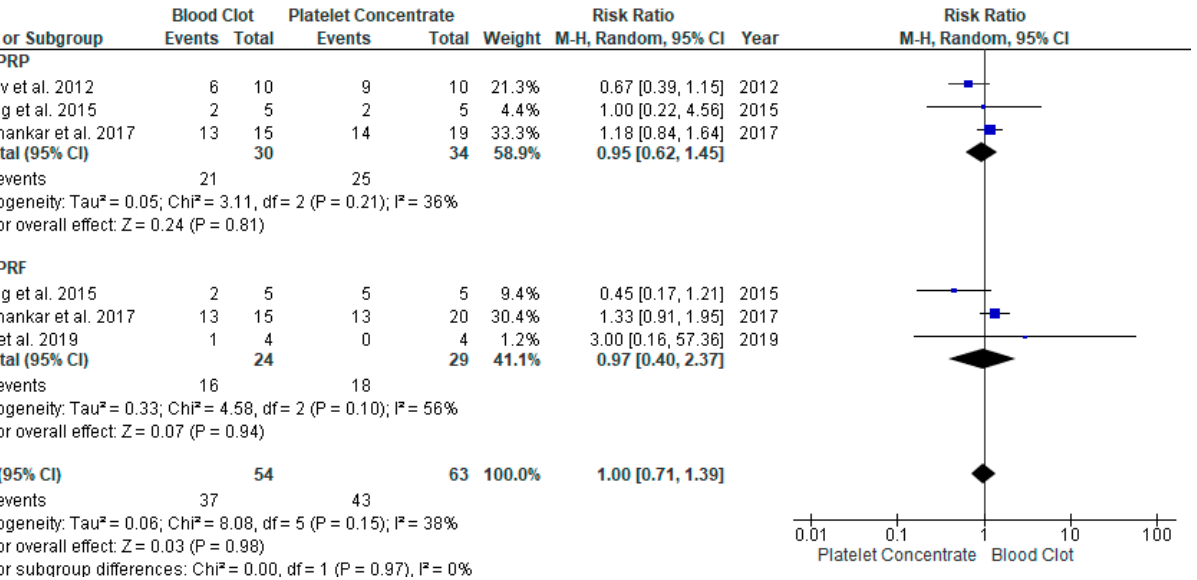
Figure 5. Meta-analysis of increased root length (IRL) in regenerative endodontic procedure (REP) using APC or BC.